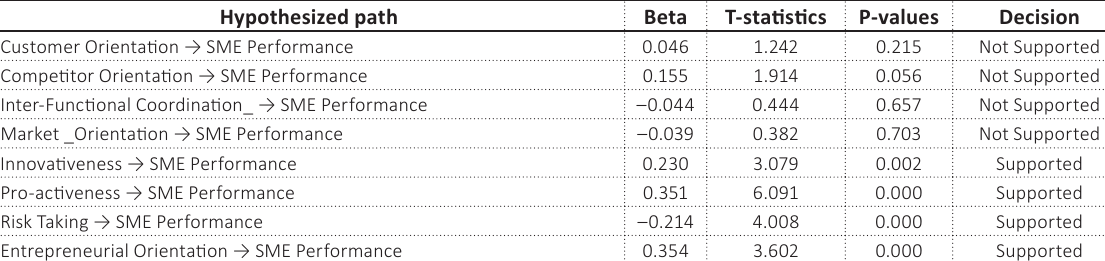
Table 8. Hypotheses